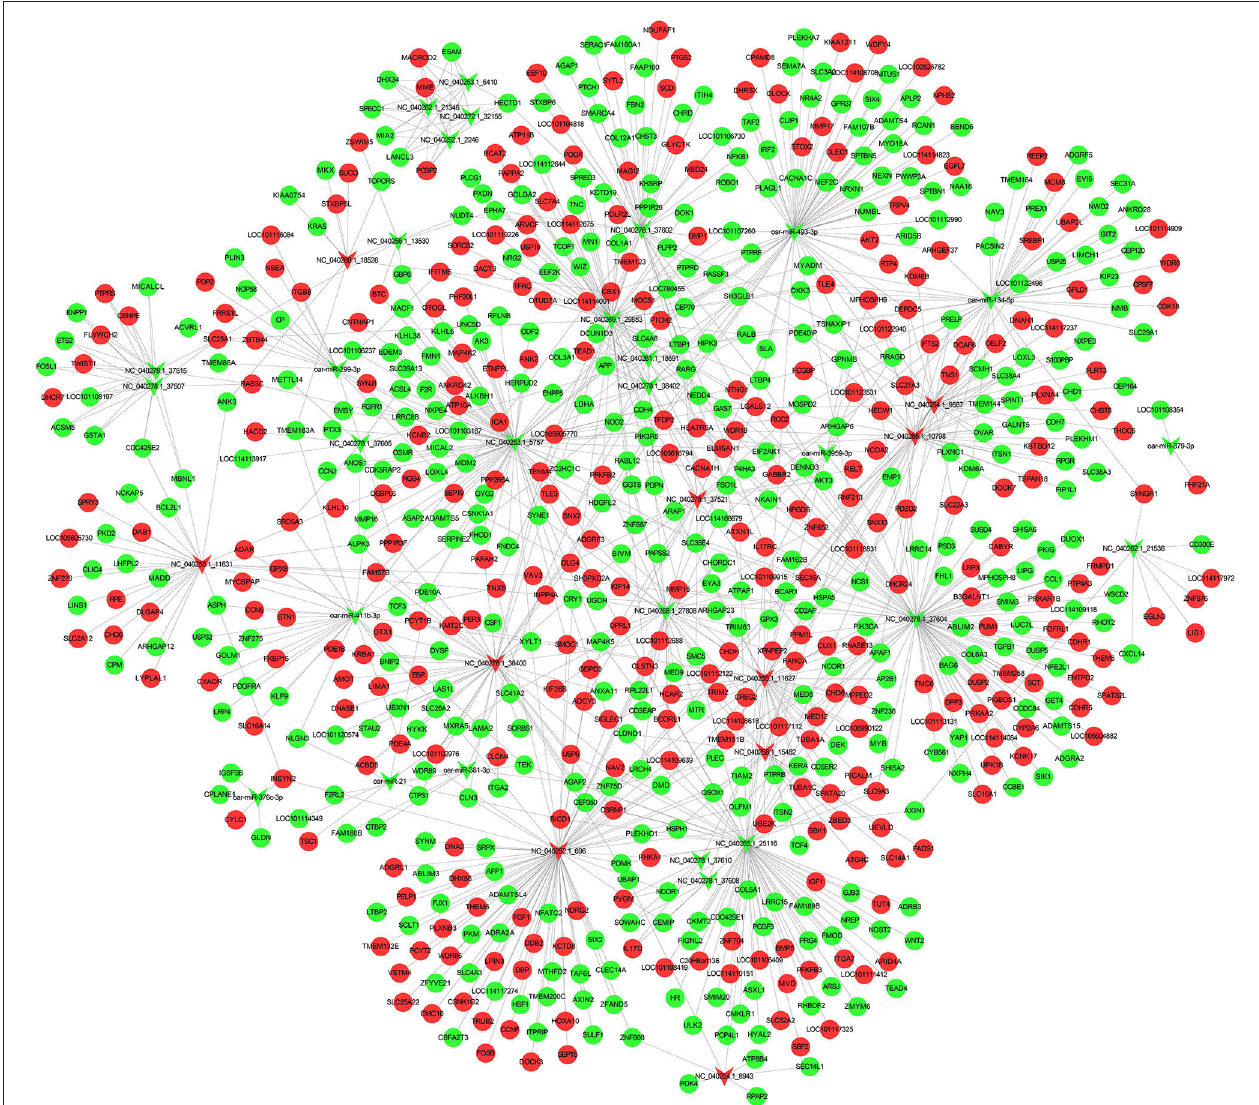
FIGURE 4 | Regulatory networks of genes. miRNA-mRNA regulatory network in sheep subcutaneous adipose tissue. The circle represents mRNA, and the arrow represents miRNA, the red represents up-regulated expression in Duolang sheep, and the green represents down-regulated expression.